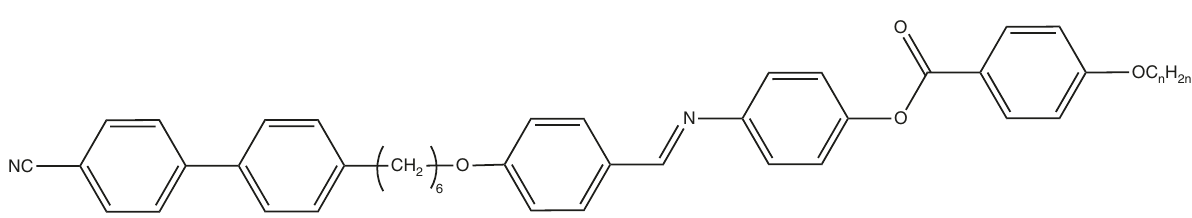
Fig. 1 Molecular structure. General molecular structure of studied homologous series